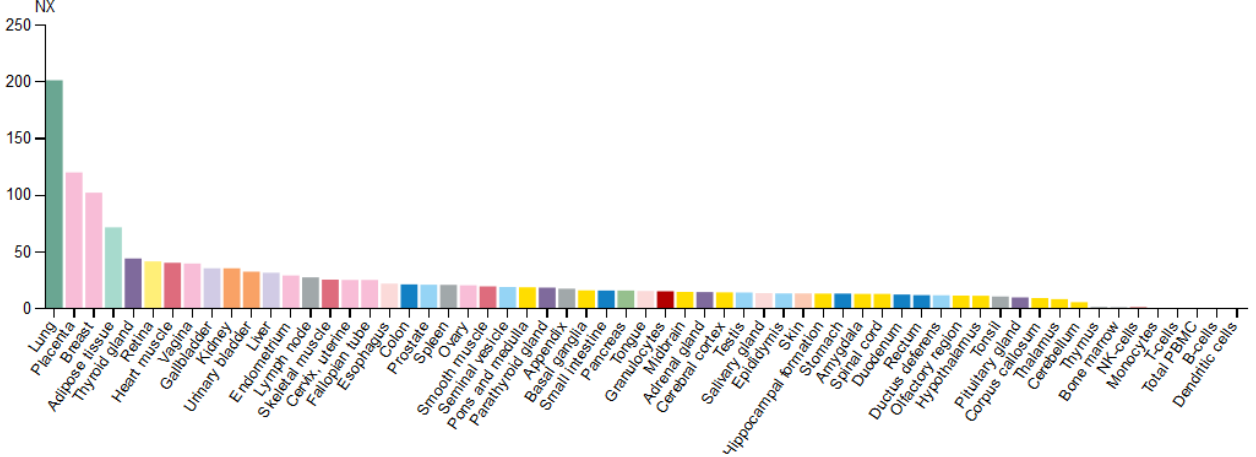
Figure 3. Expression profile of EPAS1 mRNA in various types of tissues. Normalized expression levels (NX) for 55 tissues and 6 blood cell types are obtained by combining data from the three transcriptomics datasets (HPA, GTEx, and FAN- TOM5).